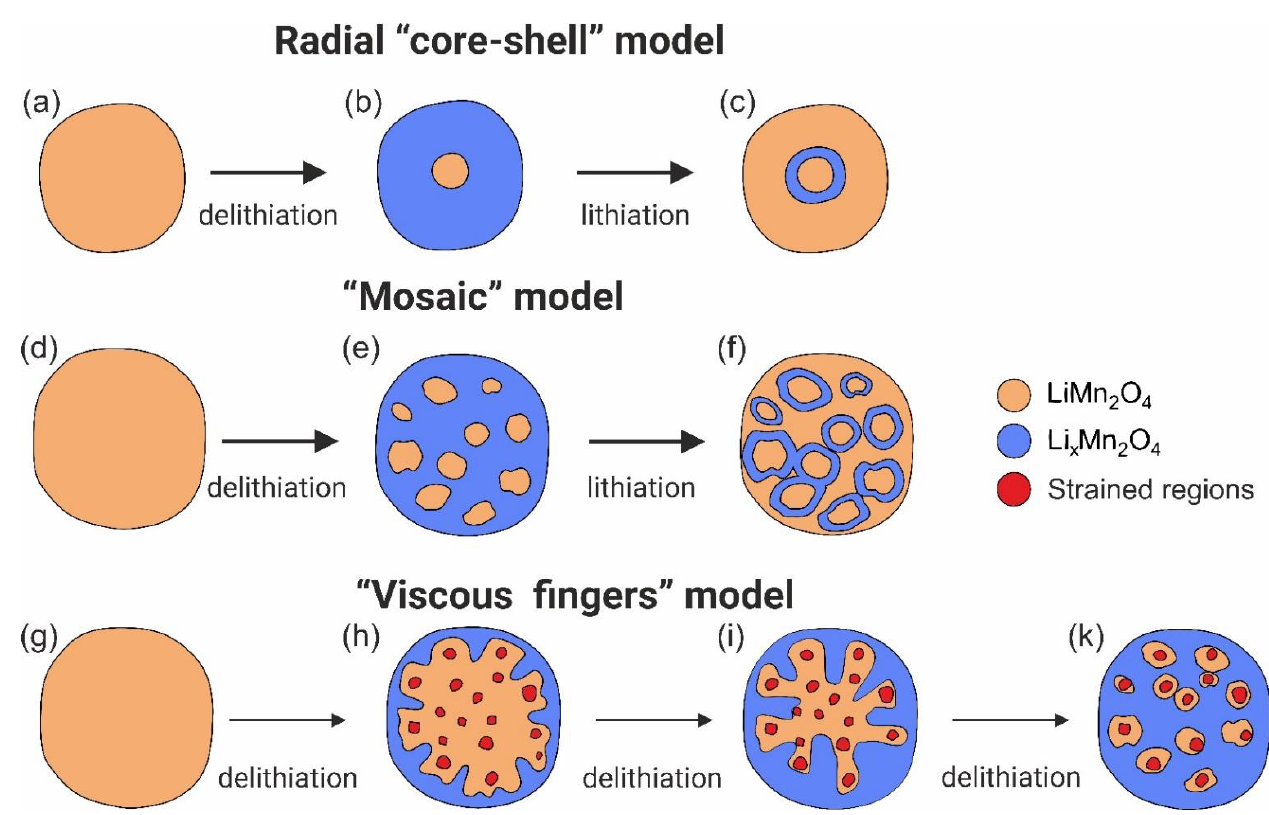
Figure 5. Kinetic models of lithiation/delithiation: ( a – c ) radial “ core – shell ” model [41,43], ( d – f ) “mosaic” model [43], ( g – k ) “viscous fingers” model.